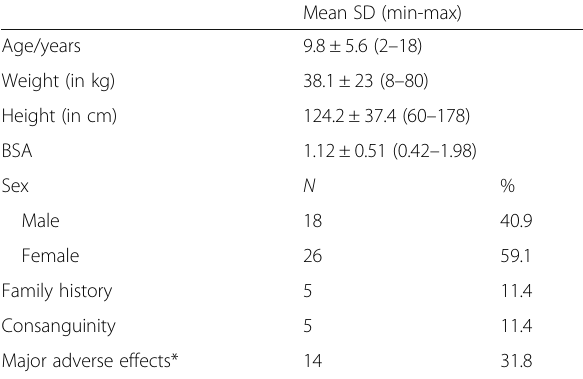
Table 1 Demographic data of studied group (44